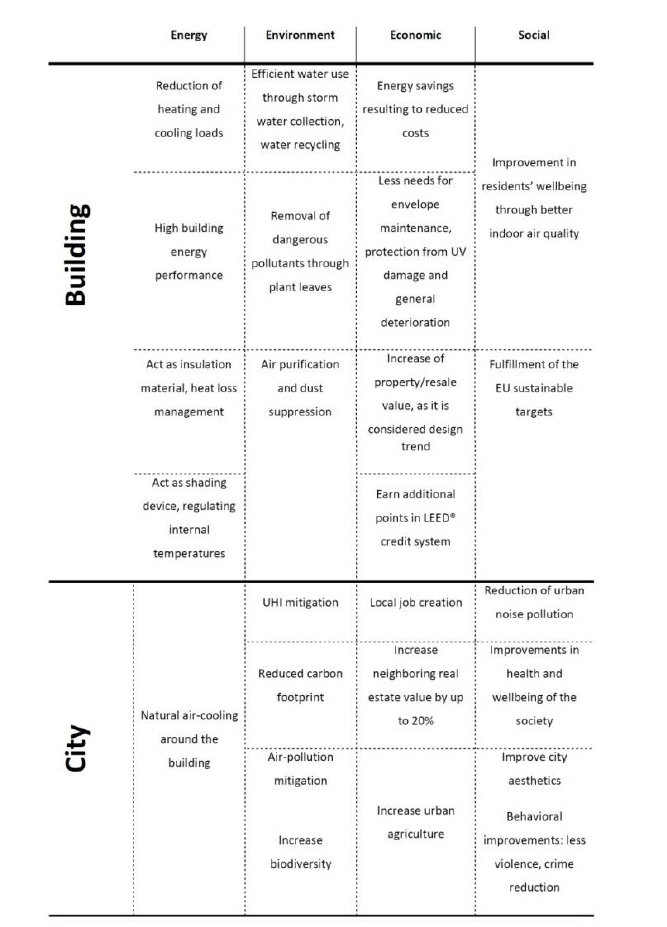
Table 9 Benefits of vertical green systems (Papadopoulou,